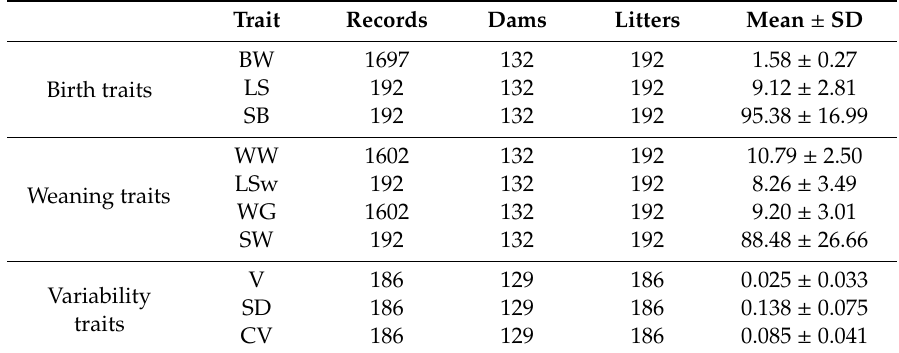
Table 1. Number of records, dams, litters, and mean and standard deviation for the analysed traits in high variability line, low variability line, and control